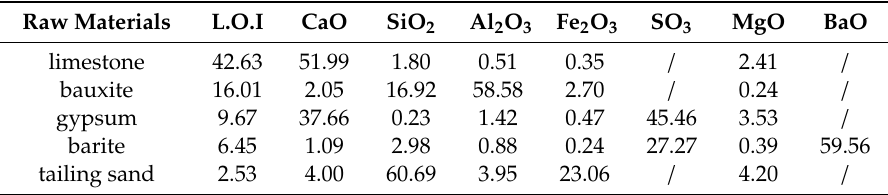
Table 1. Chemical composition of raw materials